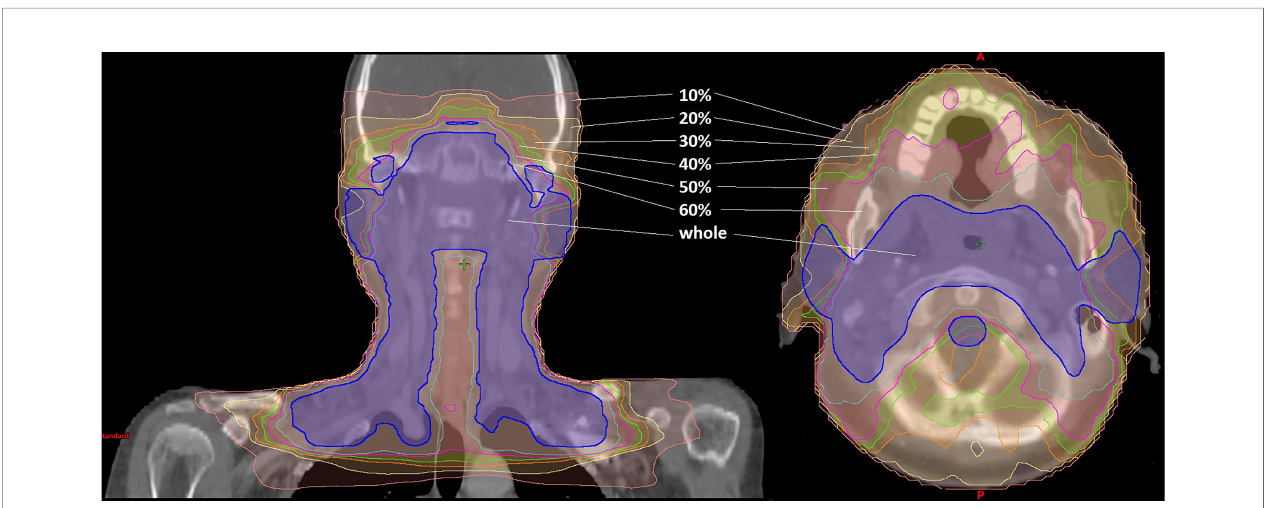
FIGURE 1 | Dose distribution of the IMRT plan for nasopharyngeal cancer. The dose distribution was divided into seven parts depicted in different colors: the pink line refers to the region of “ 10% ” label; the yellow line refers to the region of “ 20% ” label; the orange line refers to the region of “ 30% ” label; the green line refers to the region of “ 40% ” label; the magenta line refers to the region of “ 50% ” label; the cyan line refers to the region of “ 60% ” label; the blue line refers to the region of “ whole ”